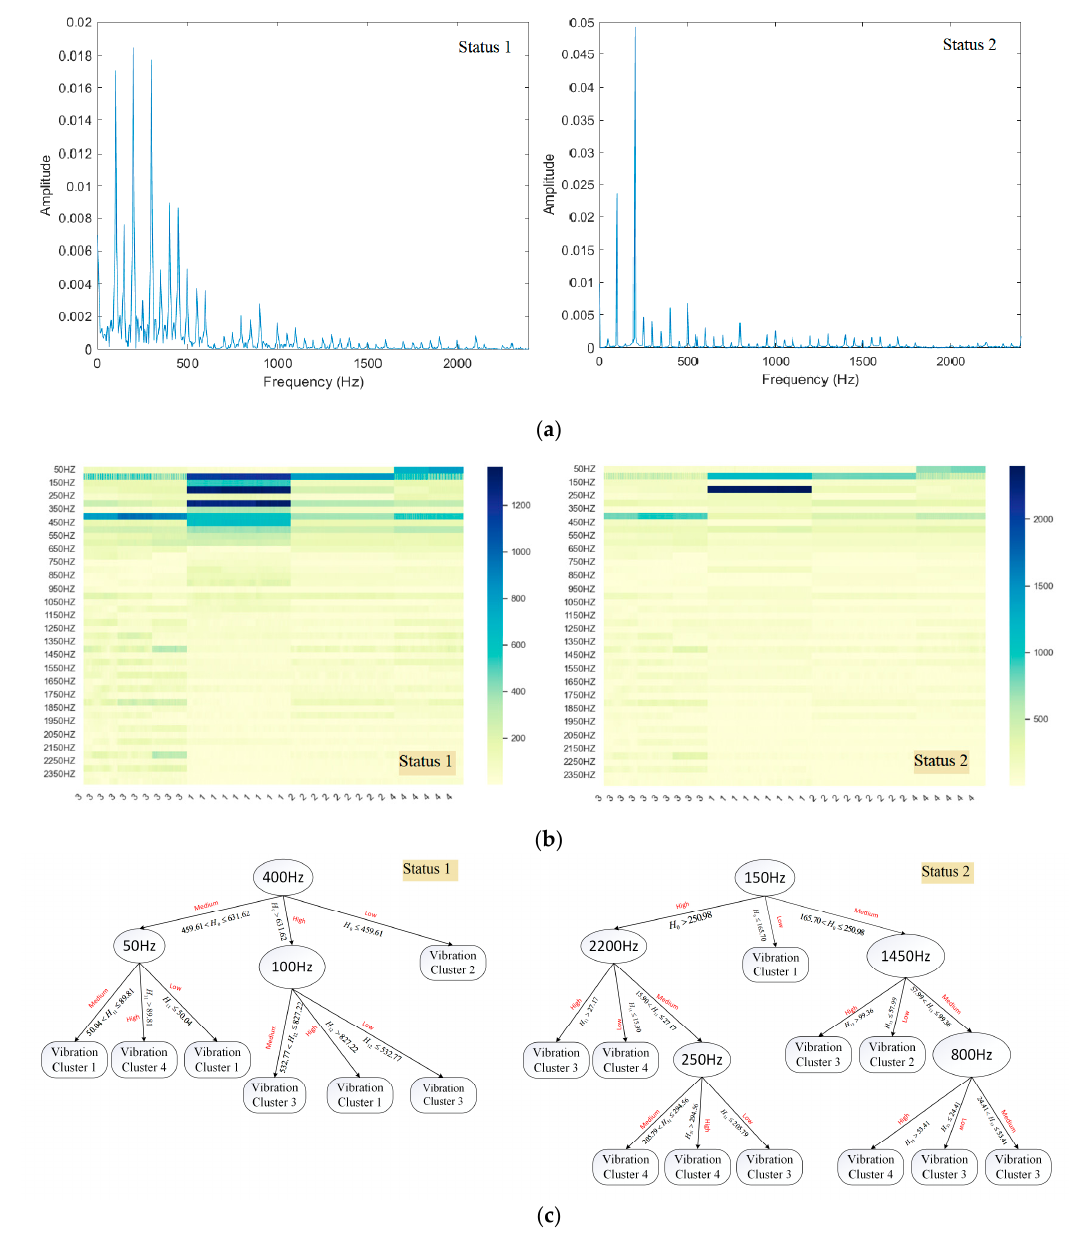
Figure 8. Vibration characteristics of transformer in two unknown states. ( a ) Spectrogram of trans- formers. ( b ) Transformer clustering heat map. ( c ) Decision tree model for a state of a transformer.